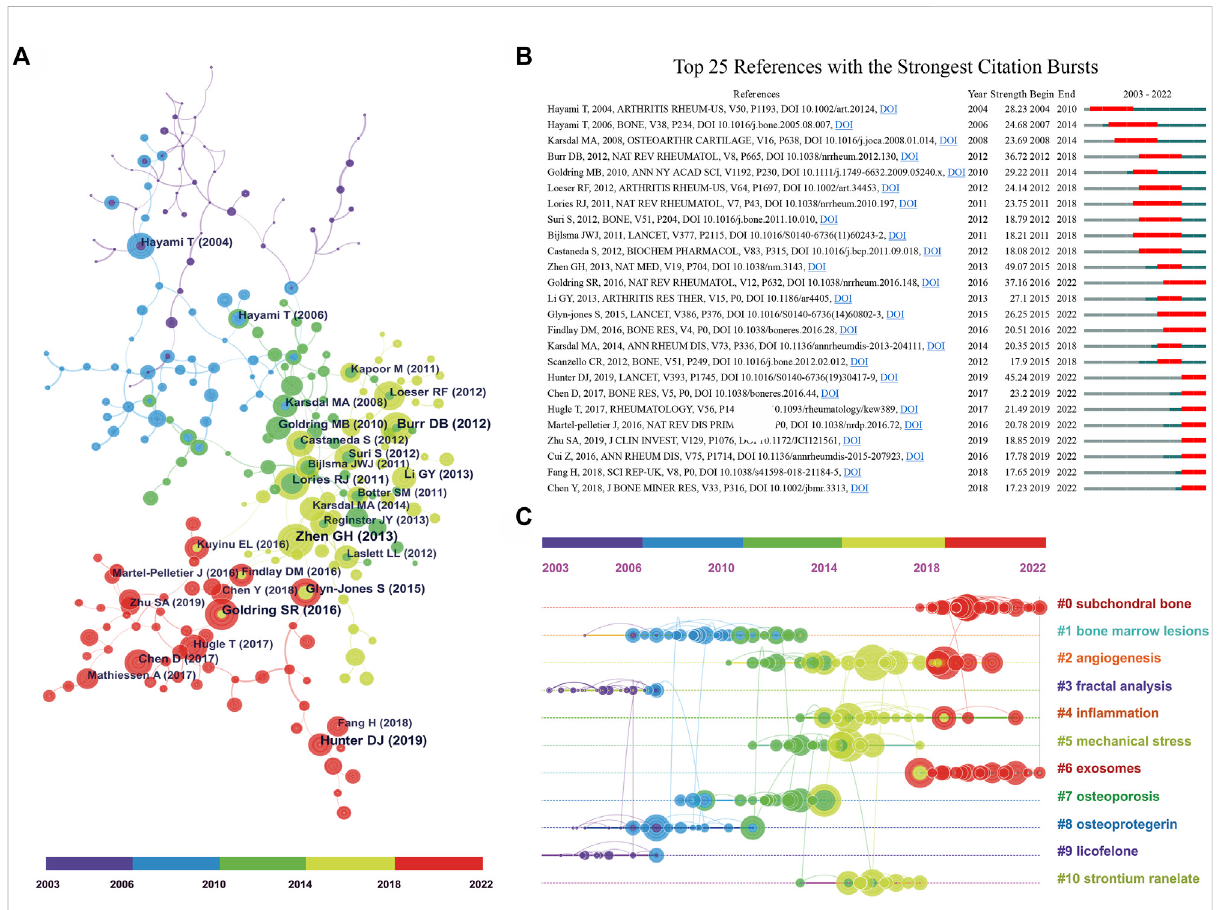
FIGURE 4 (A) The co-cited reference knowledge map. The node size represents the number of co-citations. (B) The top 25 references with the strongest citation bursts. The blue line indicates the time interval and the red part represents the period of the reference burst. (C) The timeline graph of co- cited reference